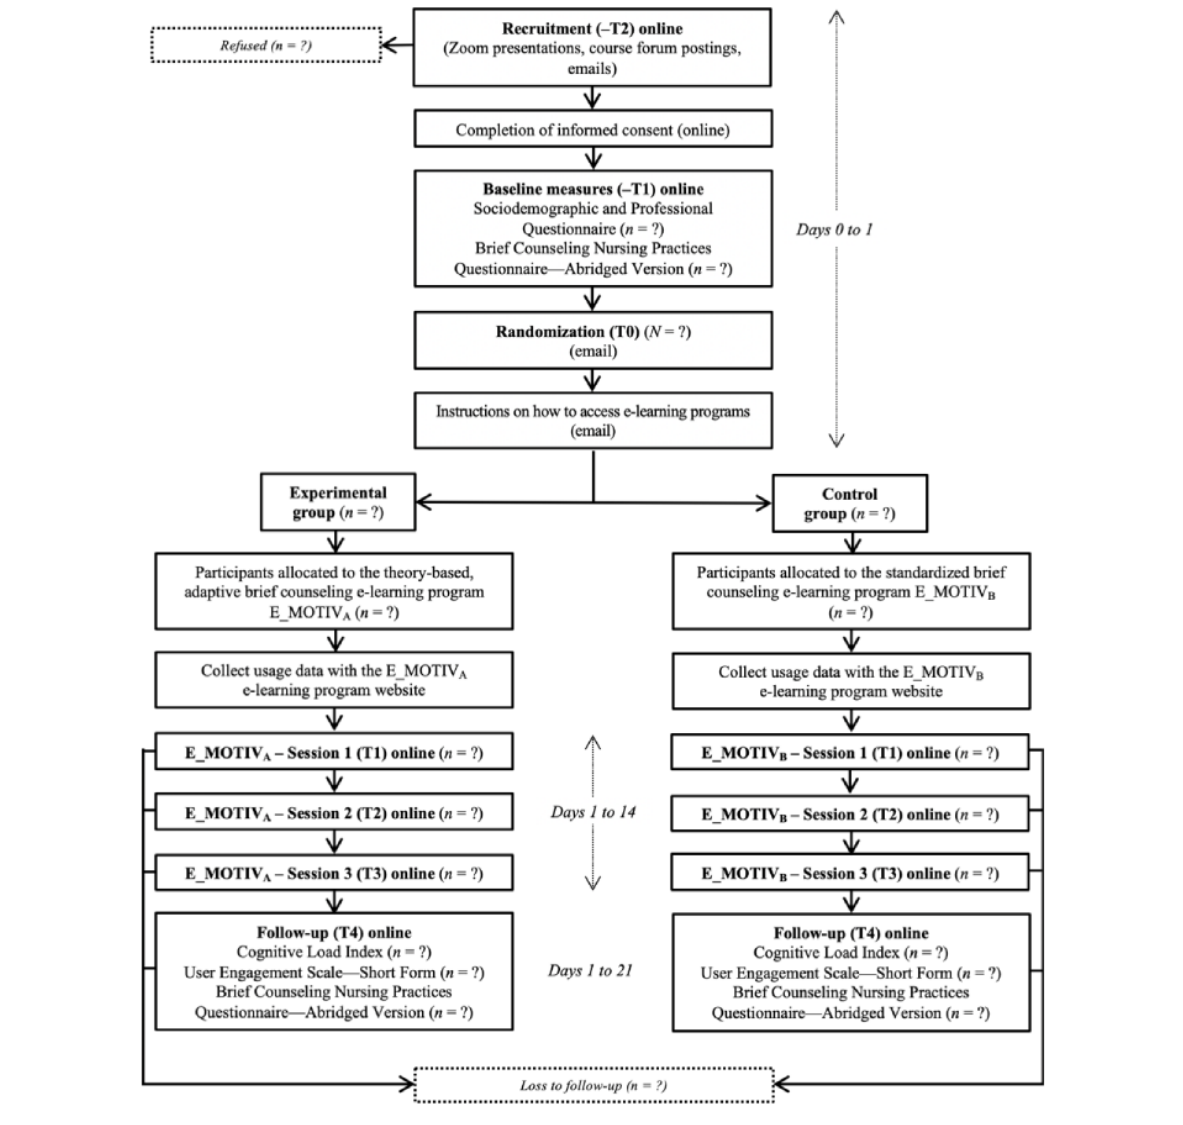
Figure 2. Participant flow